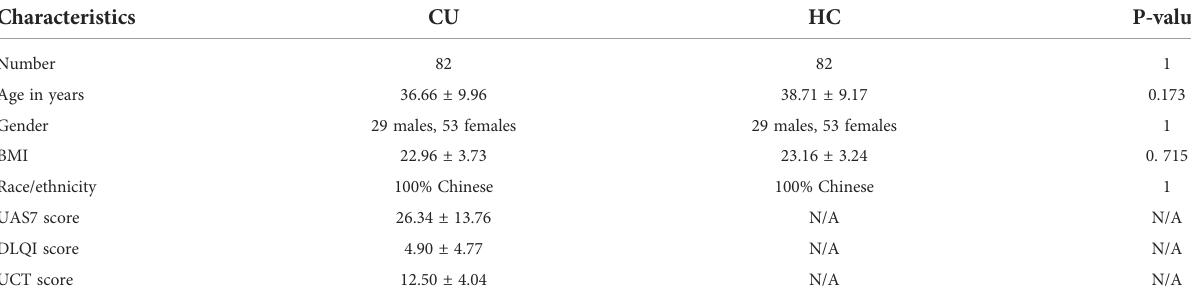
TABLE 1 Demographics of chronic urticaria patients (CU) and healthy control subjects